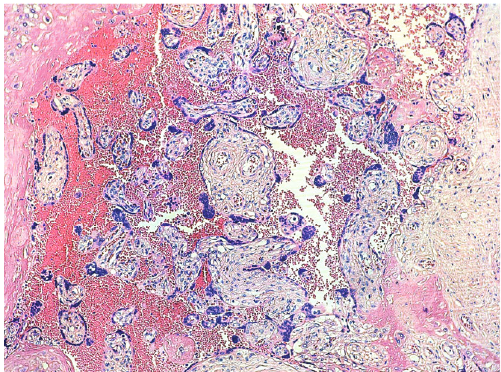
Figure 2: Haemorrhage and intravillositary thrombus, compatible with maternal vascular malperfusion (hematoxylin-eosin stain, original magni fi cation 10x).